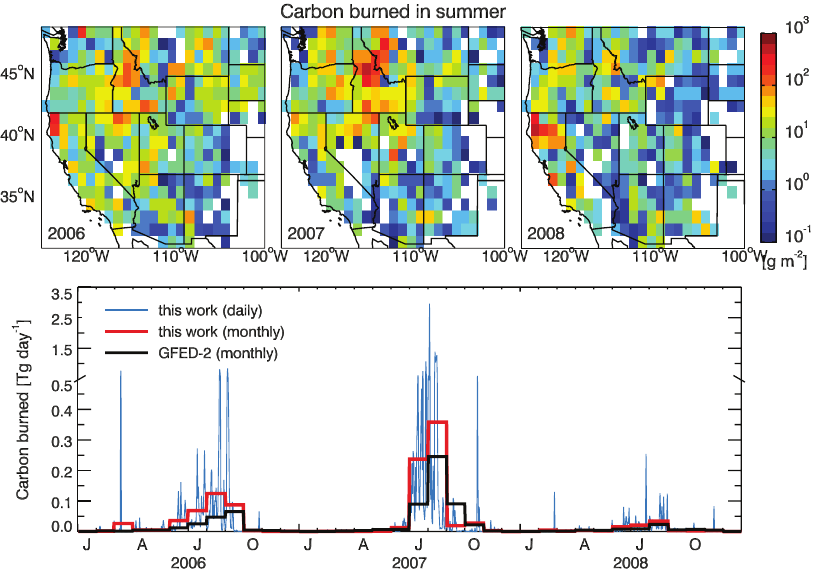
Figure 2. Wildfire emissions in the western US. The top panels show the spatial distribution of carbon burned in summer (JJA) 2006–2008 from Yue et al. (2013) as described in the text. The bottom panel shows the daily time series of wildfire emissions over the Intermountain West (120–100 ◦ W, 31–49 ◦ N) in 2006–2008. Also shown are the monthly GFED2 inventory used by Zhang et al. (2011) (black line) and the monthly means from the Yue et al. (2013) inventory. Note the break in the ordinate scale. The x axis labels represent January (J), April (A), July (J), and October (O).